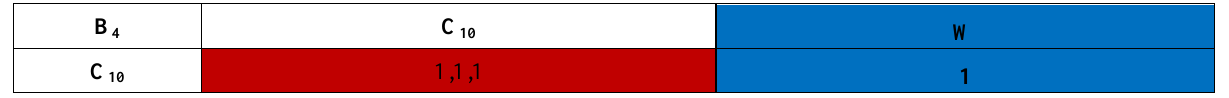
Table 8. The pairwise matrix, B